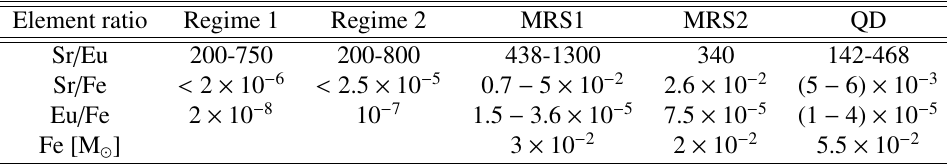
Table 1. Candidates for category CI and CII